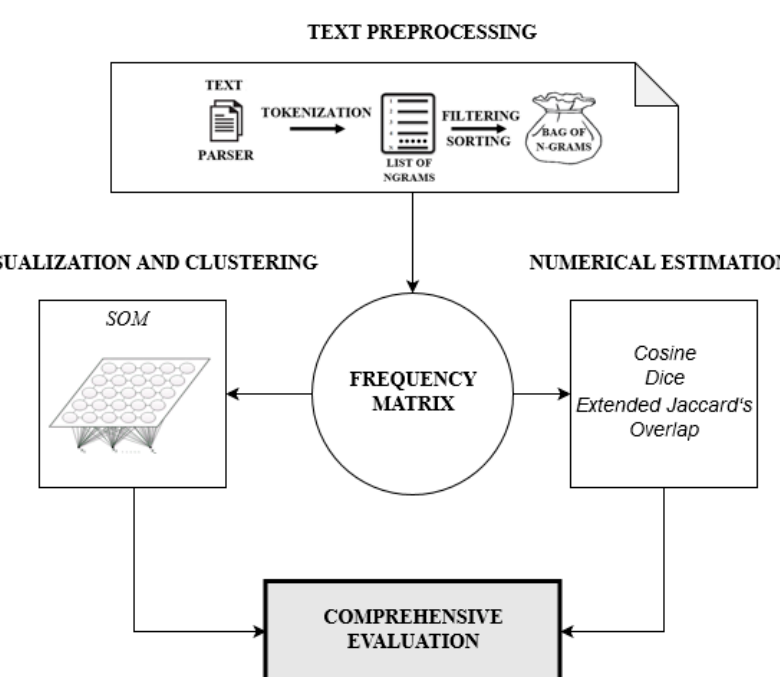
Figure 1. The scheme of the proposed approach; SOM: self-organizing maps.